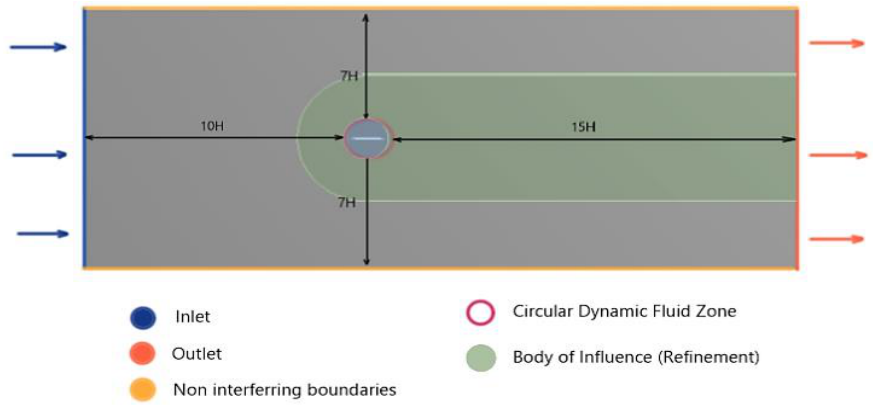
Figure 11. Computational domain for the analysis of the flapping design mechanism - II.